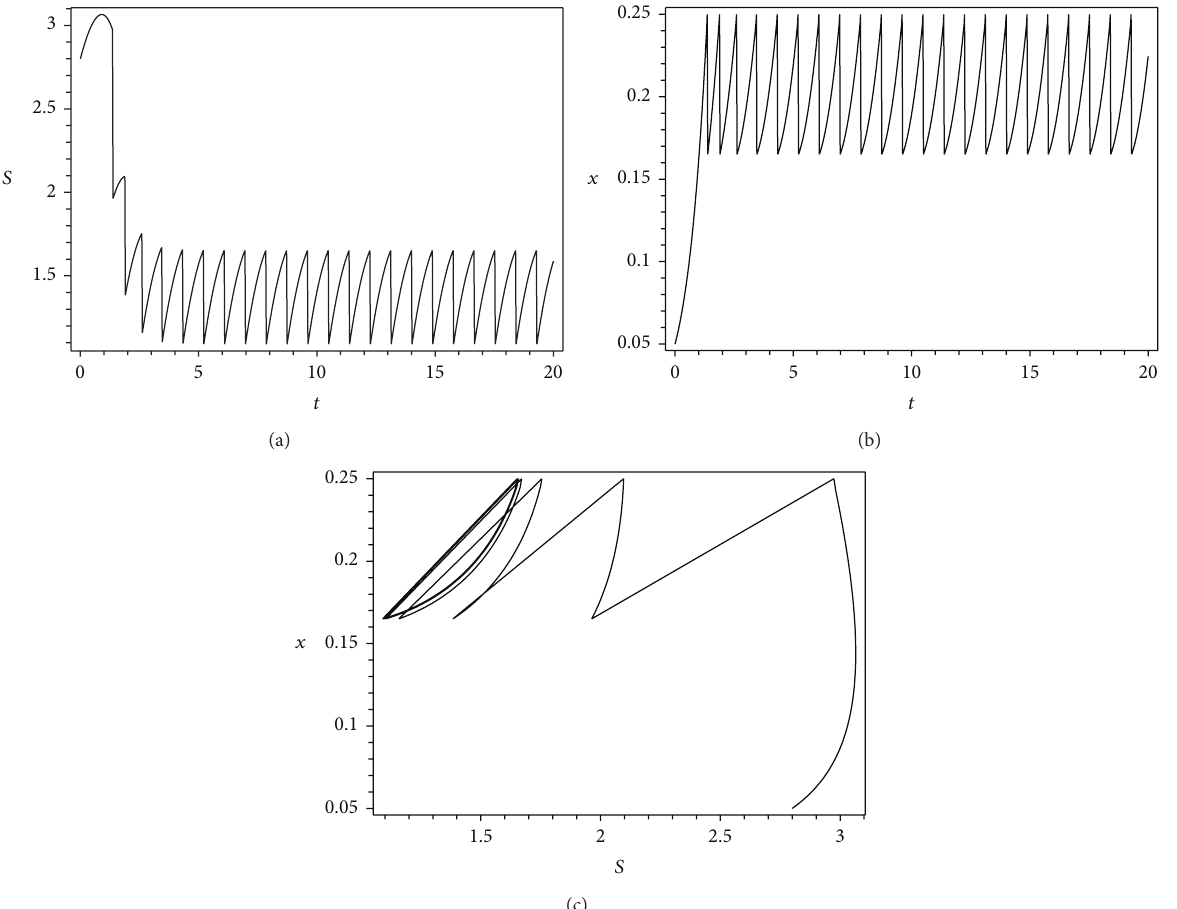
Figure 5: Time series and phase portrait of system (2) with 𝛿 1 = 0.6 , 𝐾 𝑠 = 2 , 𝑆 𝑖 = 4.7 , 𝐷 = 0.4 , 𝜇 = 3.8 , 𝐾 𝑑 = 0.7 , 𝑏 = 0.34 , 𝑆 0 = 2.8 , 𝑥 0 = 0.05 , ℎ = 0.25 < 𝑆 ∗